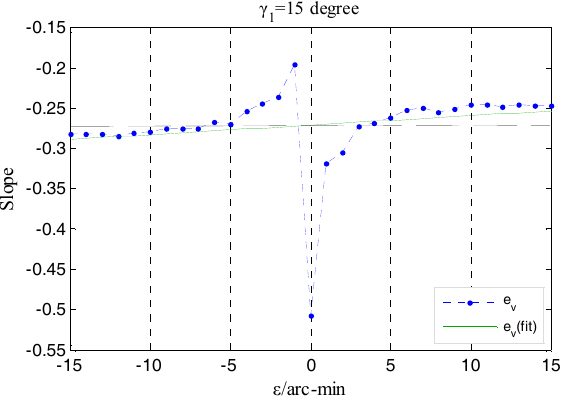
Figure 29. The slope variation for single-step.